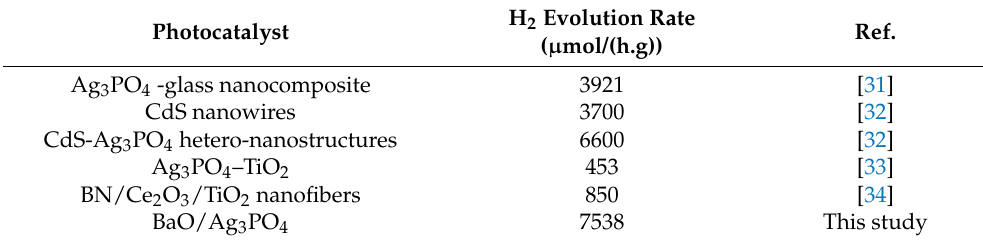
Figure 8. Comparison of the photocatalytic activity of the pure Ag 3 PO 4 and BaO@Ag 3 PO 4 nanocom- posite samples for photocatalytic hydrogen production. Table 2. Photocatalytic activity of various photocatalysts.